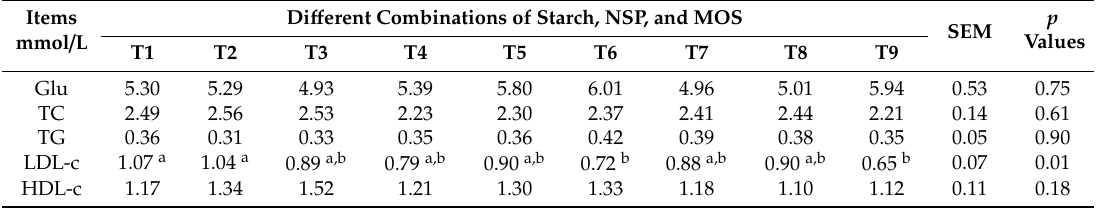
Table 8. E ff ects of di ff erent combinations of starch, NSP, and MOS on the blood biochemical parameters of weaned pigs.